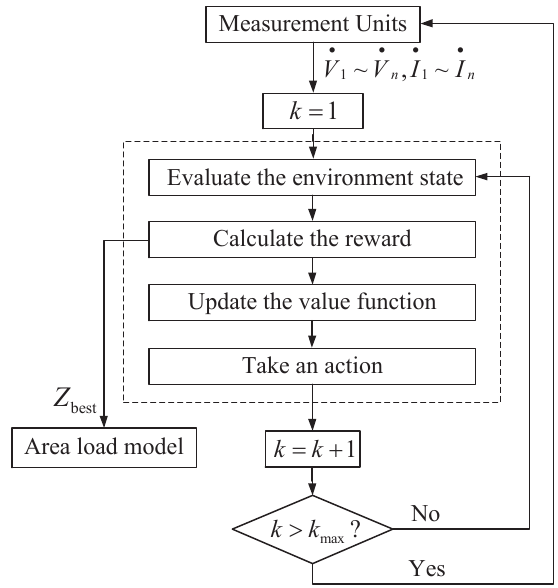
Figure 2. Flowchart of the online parameter tracking process implemented by means of the enhanced reinforcement learning (ERL)